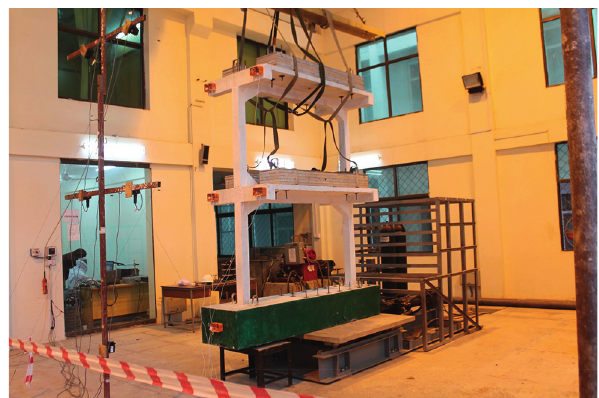
Figure 5: 1 :3 reduced scale model prepared for shake table